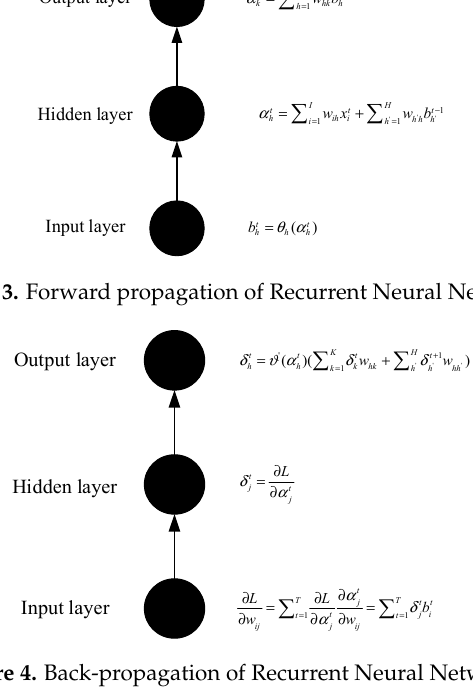
Figure 4. Back-propagation of Recurrent Neural Networks.